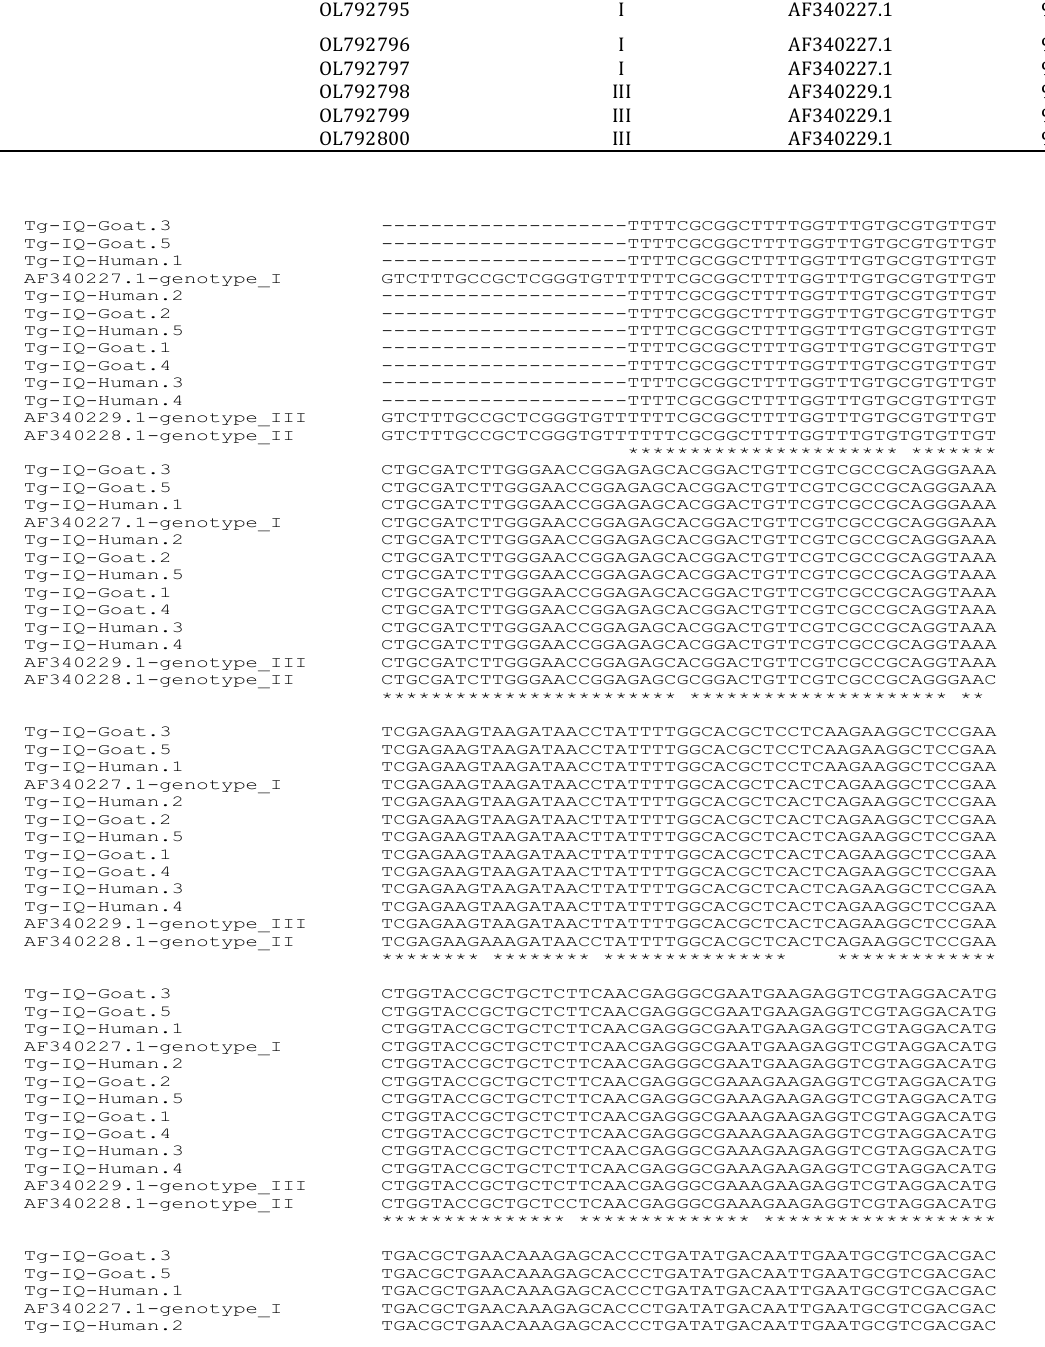
Figure 4. Multiple sequence alignment analysis of Toxoplasma gondii surface antigen (SAG3) gene complete sequence in local goats and human blood-positive samples with NCBI-GenBank Toxoplasma gondii genotypes isolates. The multiple alignment analysis was constructed using (The clustalW alignment tool. Online). That alignment analysis showed the nucleotide alignment similarity as (*) and substitution mutations in the SAG3 gene between